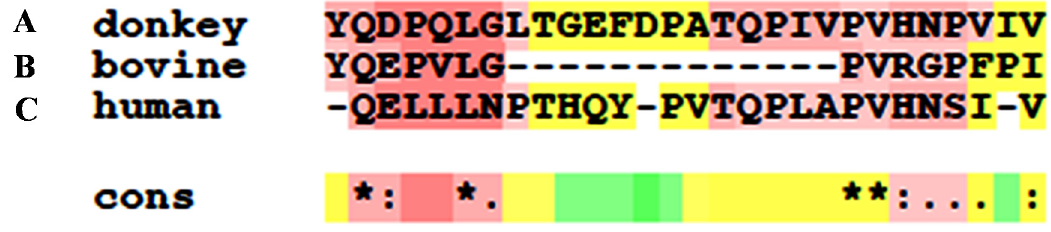
Figure 4. Alignment of fragments derived from the β‐ casein digestion with anti ‐ hypertensive properties: ( A ): donkey’s β‐ casein fragment 199–226; ( B ): human β‐ casein fragment 184–210; ( C ): bovine β‐ casein fragment 193–198 [45]. Sequence alignment was performed by T ‐ COFFEE, Version_11.00 [74].